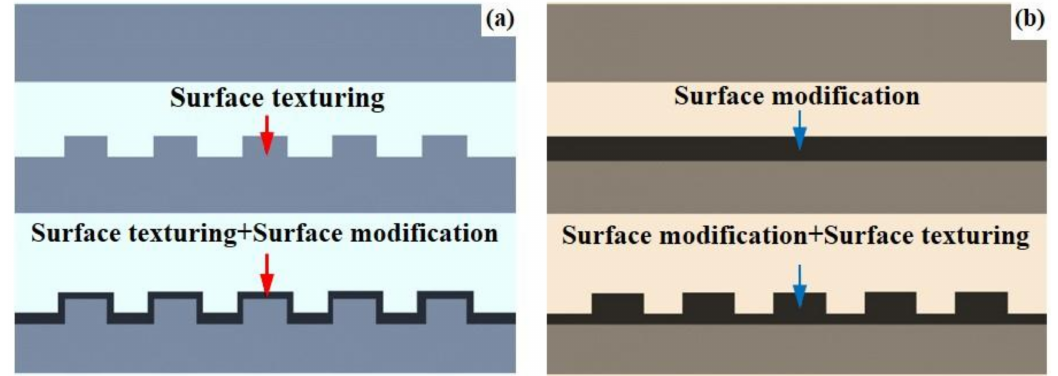
Figure 2. Schematic diagram of duplex treatment: ( a ) type one: surface texturing + surface modification; ( b ) type two: surface modification + surface texturing.